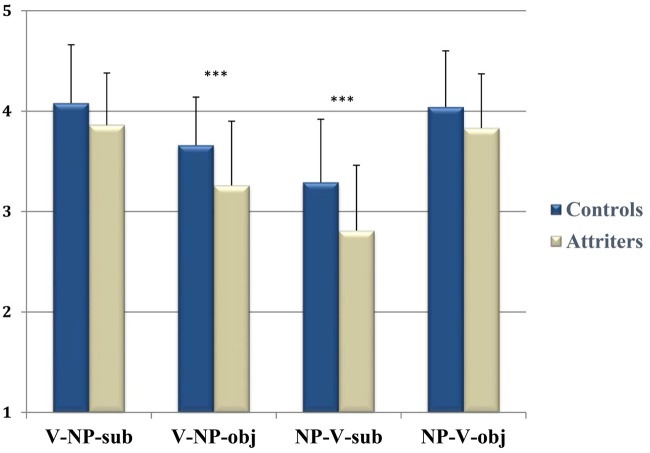
Group acceptability ratings on a scale from 1 (completely unacceptable) to 5 (perfect) by condition. Attriters rated V-NP-o and NP-V-s sentences significantly less favorably than Controls (∗∗∗p < 0.005). Error bars represent standard deviation.